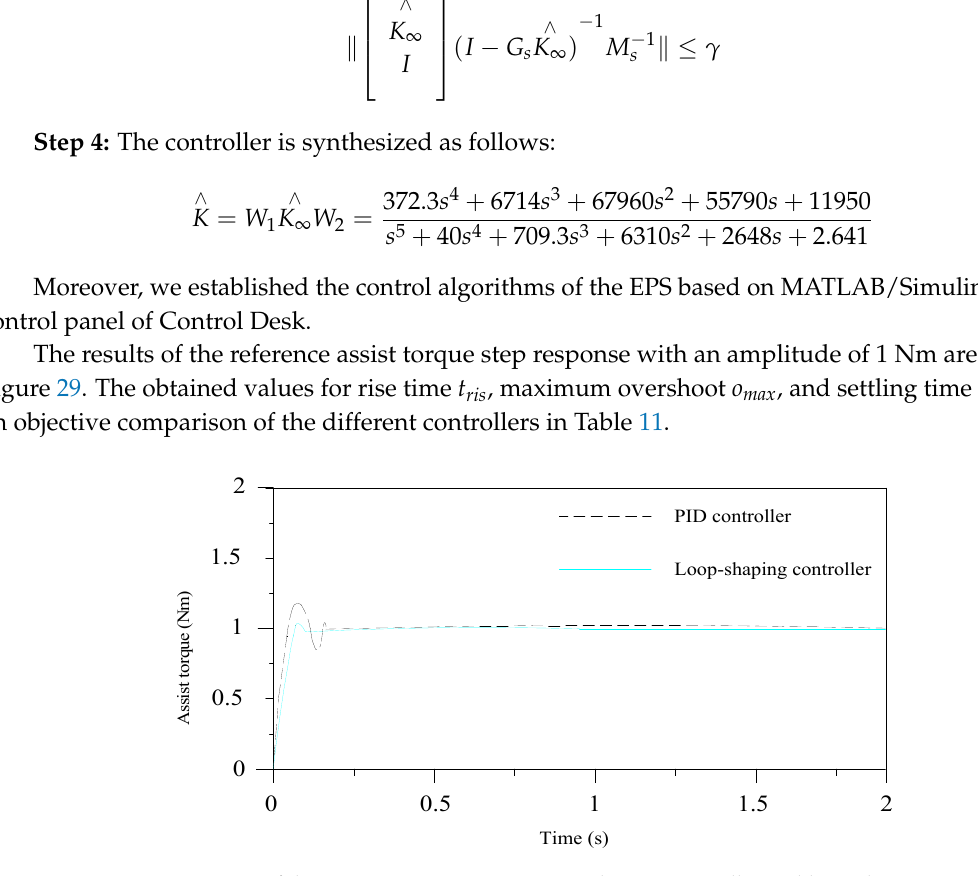
Figure 29. Comparison of the assist torque response using the PID controller and loop-shaping controller. Table 11. Results of the 1 Nm reference assist torque response.